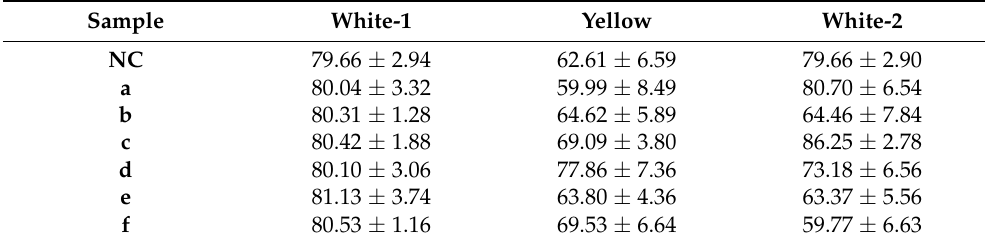
Table 3. Lipid peroxidation in soy beverage in the presence of corn by-product extracts. Values are expressed in TBARS (nmoles/mL of extract) utilizing the molar extinction coefficient. Sample White-1 Yellow White-2 NC 79.66 ±